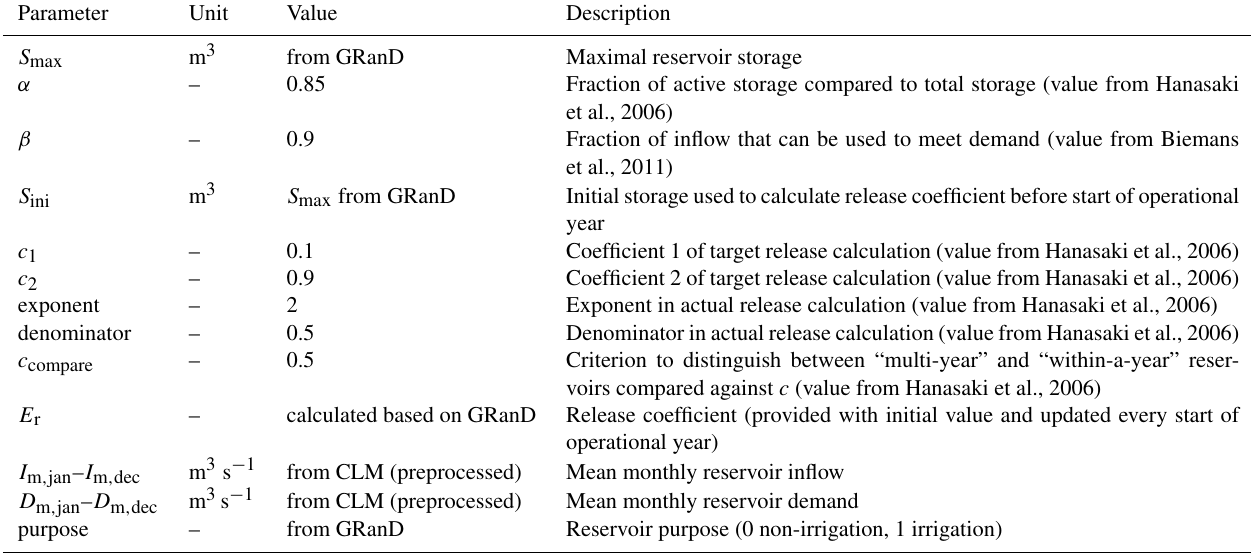
Table A1. Parameters for the Hanasaki et al. (2006) reservoir parametrization in mizuRoute.